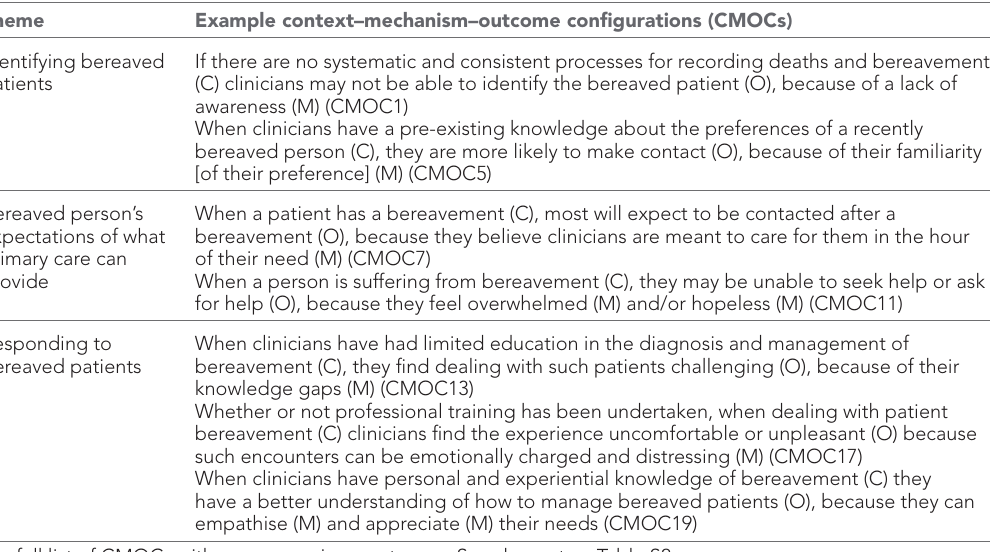
Table 1 Themes with accompanying examples of context–mechanism–outcome configurations Theme Example context–mechanism–outcome configurations (CMOCs)